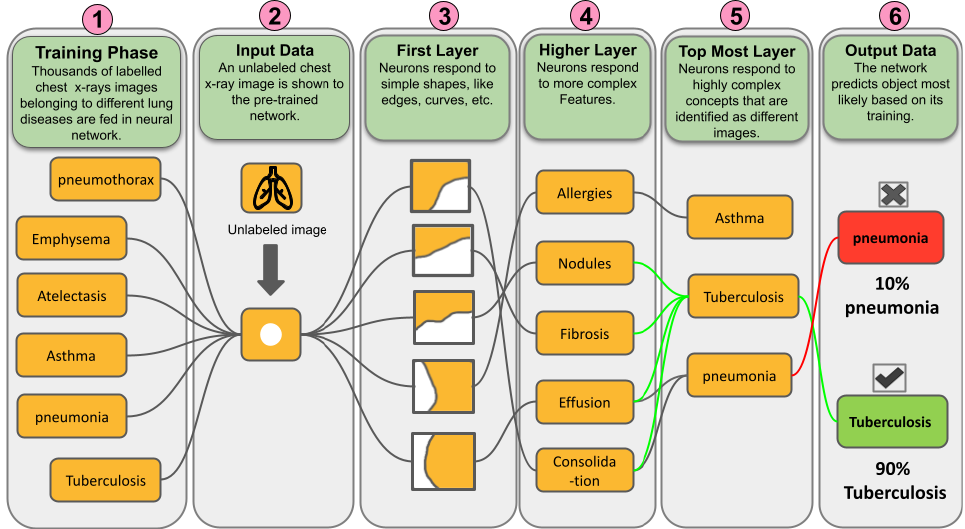
Figure 5. Representation of working of a CNN model for TB diagnosis.